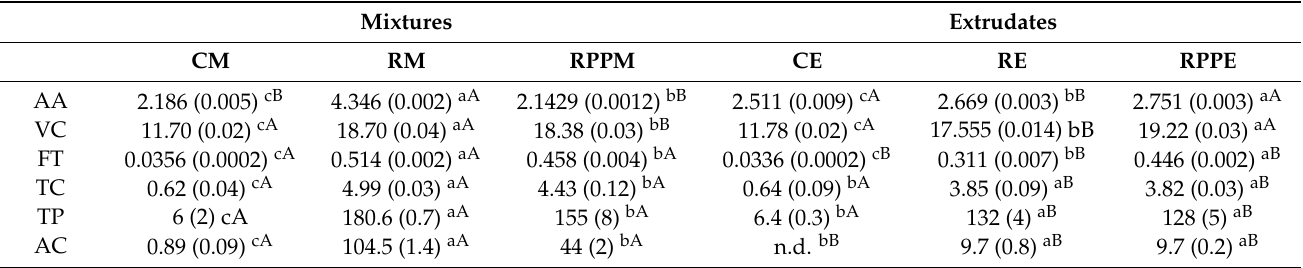
Table 5. Mean values (and standard deviations) of corn mixtures’ and extrudates’ component content after in vitro